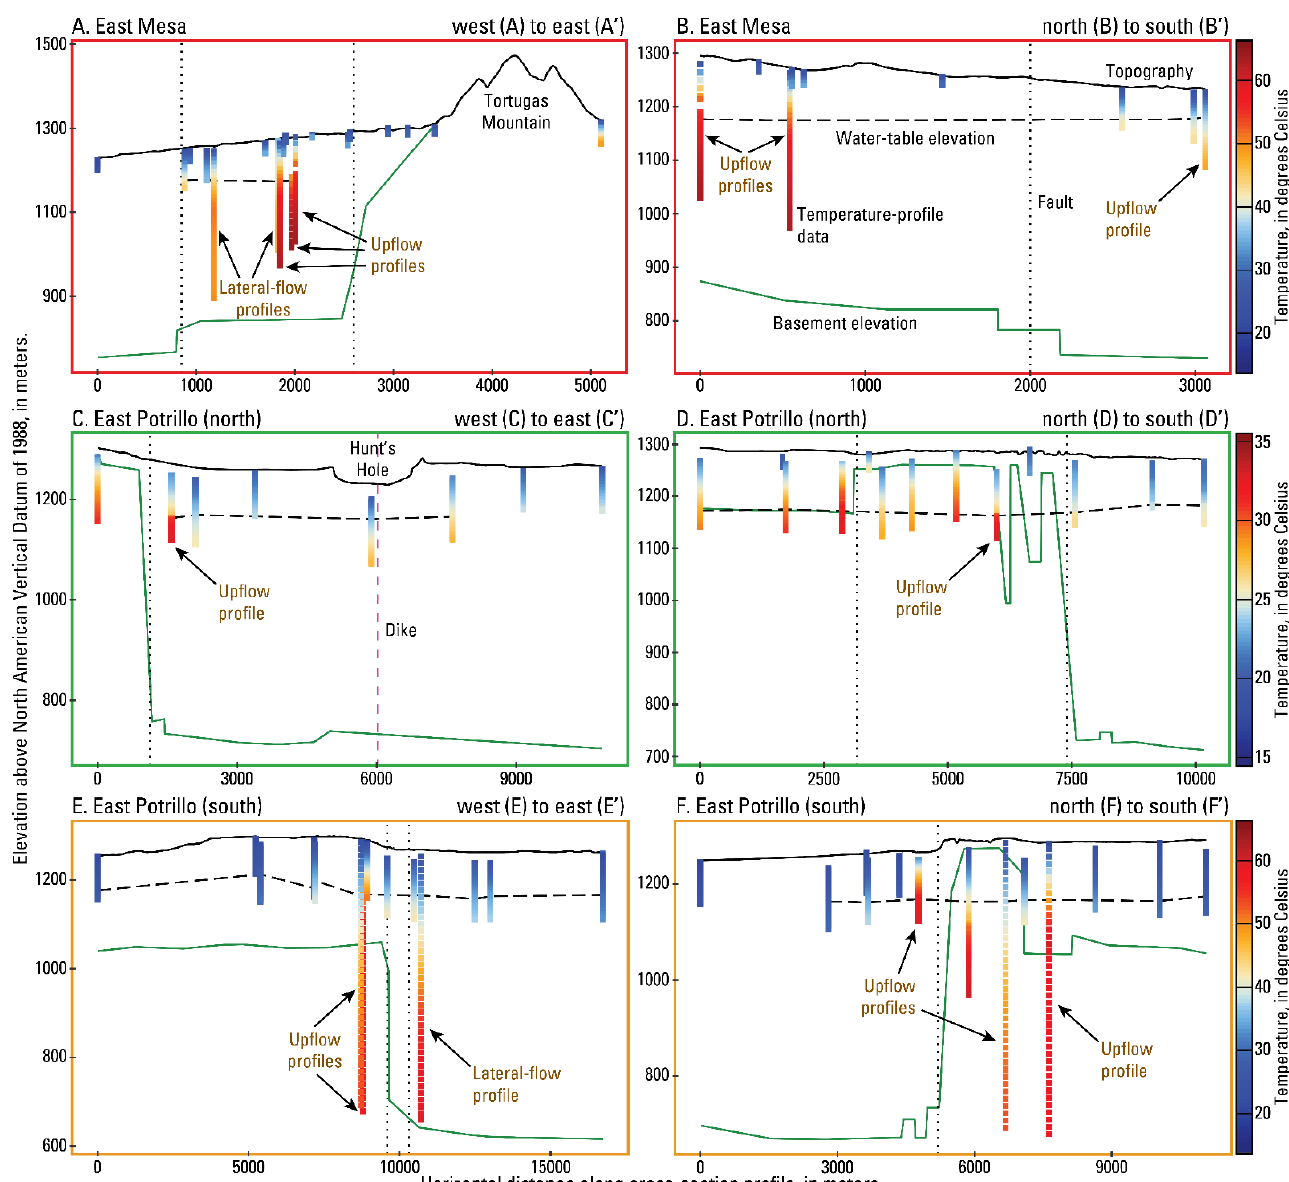
Figure 5. East – west and north – south thermal cross sections for the East Mesa ( A,B ), East Potrillo (north) ( C,D ) and East Potrillo (south) ( E,F ) upflow zones. These plots include temperature observations overlain onto basement stratigraphy, dikes, and faults from Sweetkind (2017) [27]. Additionally, topography from a USGS 1/3 arc-second (about 10 m) digital elevation model [41] is shown along with water table elevations estimated from the well records, smoothed temperature profiles and their derivatives, and nearby USGS water level data [23]. The temperature scale differs for the East Potrillo (north) cross sections ( C , D ) relative to the other cross sections. Surface projections are used to plot dikes and faults and their corresponding dips are not depicted.